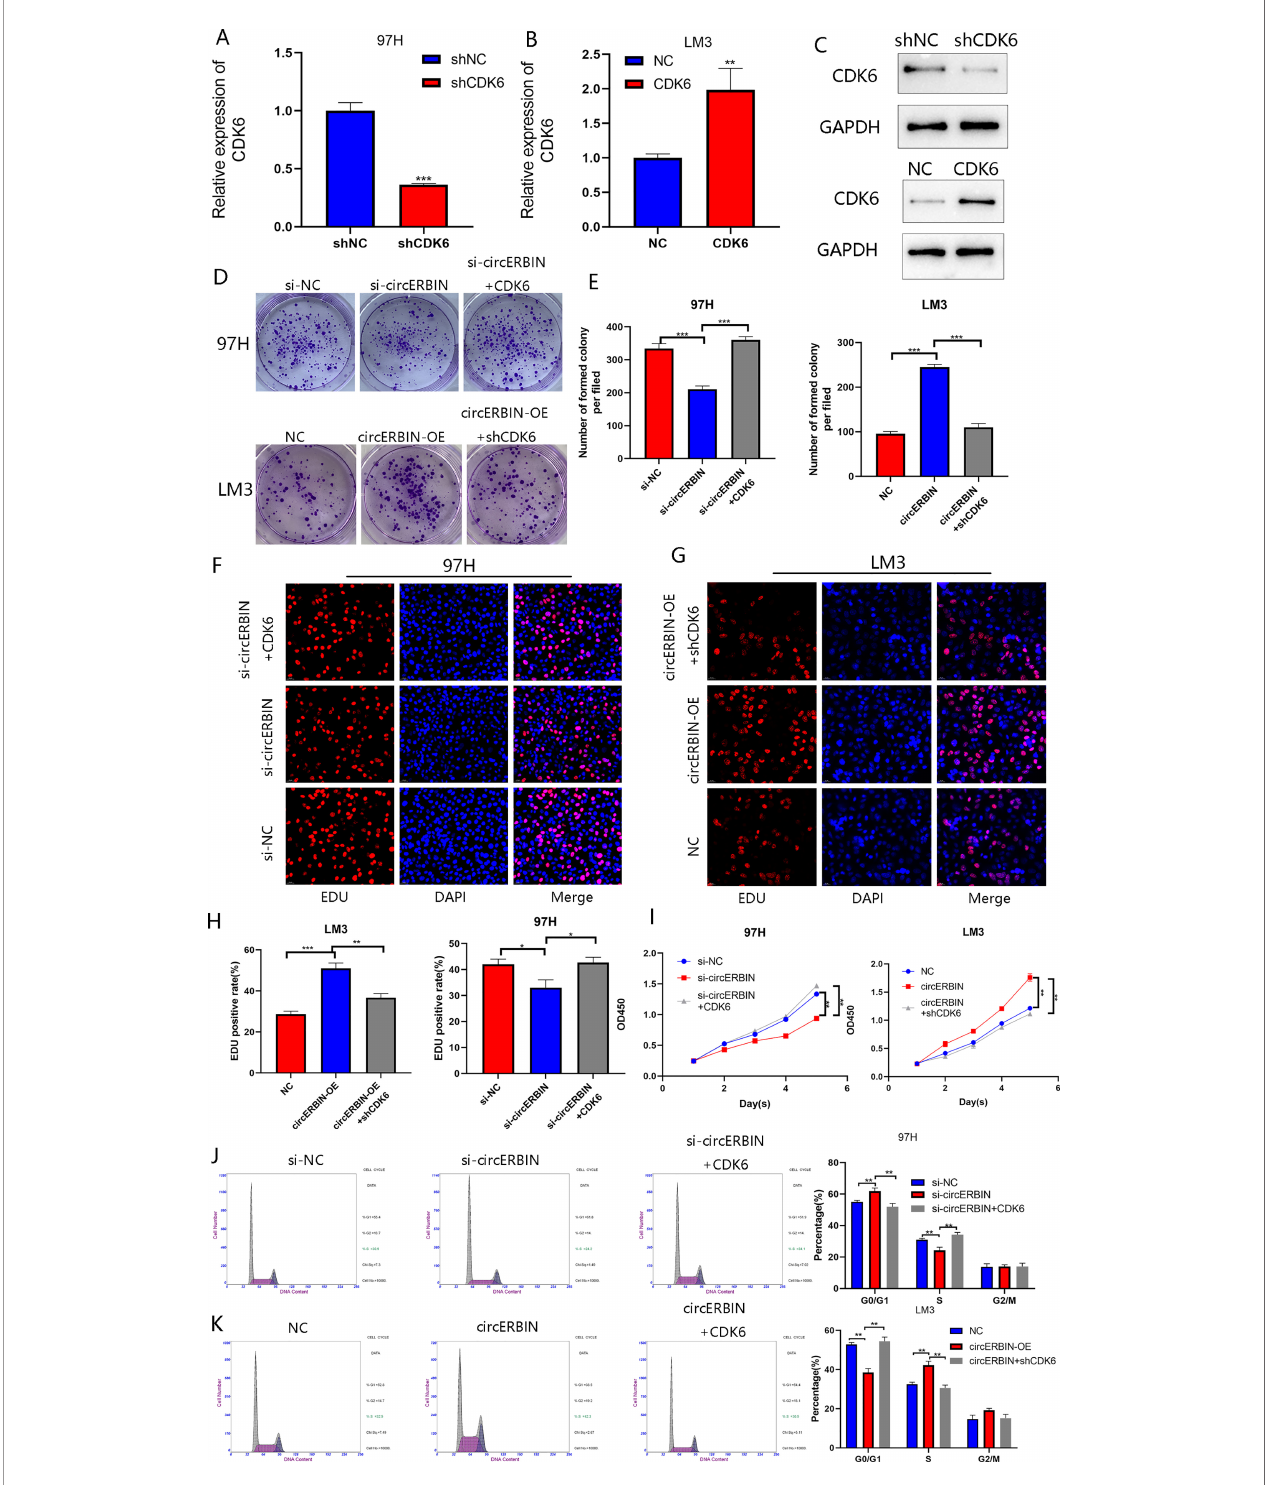
FIGURE 7 | CircERBIN promotes the progression of HCC via the miR-1263/CDK6 axis. (A – C) Relative expression of CDK6 in 97H and LM3 cells transfected with shCDK6, CDK6, or NC as detected by qRT-PCR and western blot analyses. (D – I) The effects of circERBIN and CDK6 on HCC cells proliferation in HCC cell lines were evaluated by colony formation, EdU cell proliferation, and CCK-8 assays. (J, K) Flow cytometry showing that circERBIN and CDK6 affect G1 to S phase transition. (* p < 0.05, ** p < 0.01, *** p < 0.001).